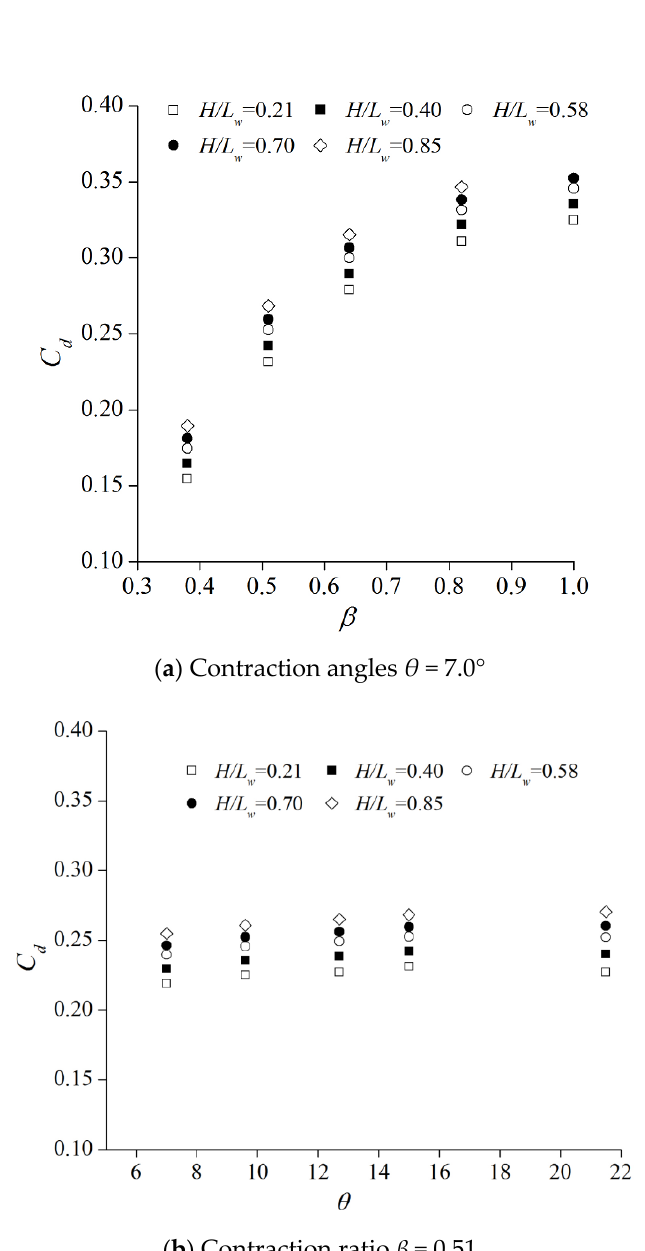
Figure 9. Discharge coefficient C d versus β ( a ) and θ ( b ).